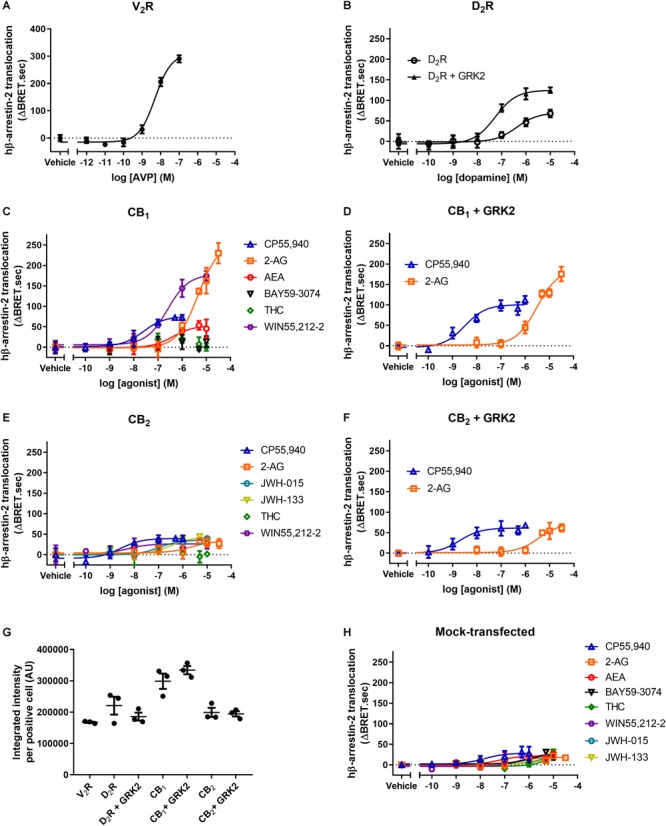
hβ-arrestin-2 translocation to V2R, D2R, CB1, and CB2. hβ-Arrestin-2 translocation to plasma membrane in cells expressing (A) V2R stimulated with AVP, (B) D2R with or without co-expressed GRK2 stimulated with dopamine, (C) CB1 stimulated with CP55,940, 2-AG, AEA, BAY, THC, and WIN55,212-2, (D) CB1 with co-expressed GRK2 stimulated with CP55,940 and 2-AG, (E) CB2 stimulated with CP55,940, 2-AG, JWH-015, JWH-133, THC, and WIN55,212-2, and (F) CB2 with co-expressed GRK2 stimulated with CP55,940 and 2-AG. (G) Receptor expression of V2R, D2R, D2R+GRK2, CB1, CB1+GRK2, CB2, and CB2+GRK2 in cells used in experiments (A–G). Receptor expression was quantified in cells positive for expression by ICC. (H) hβ-Arrestin-2 translocation to plasma membrane in mock-transfected cells. Error bars are ±standard deviation of representative data with three technical replicates (A–F), or standard error of the means from three independent biological replicates (G,H).